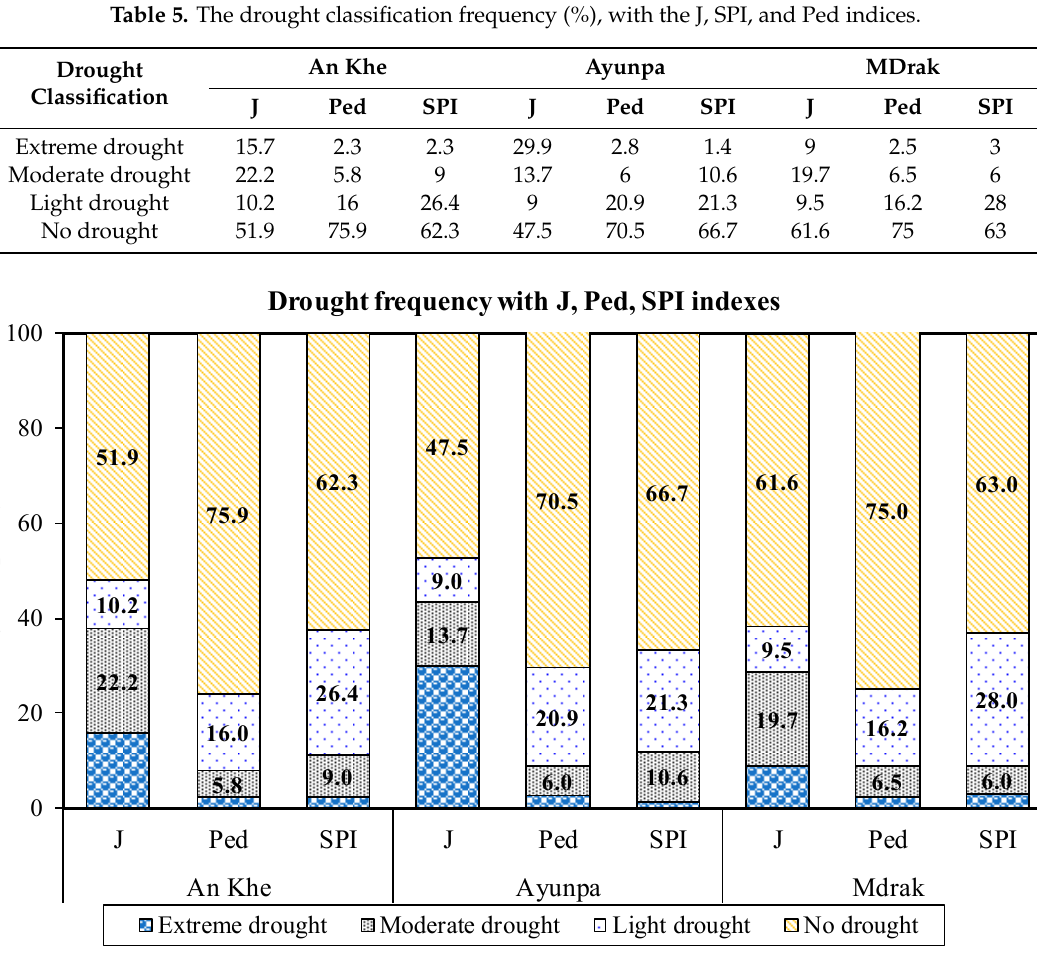
Figure 5. The frequency distribution of drought classification at the An Khe, Ayunpa, and Mdrak stations according to the J, Ped, and SPI indices.